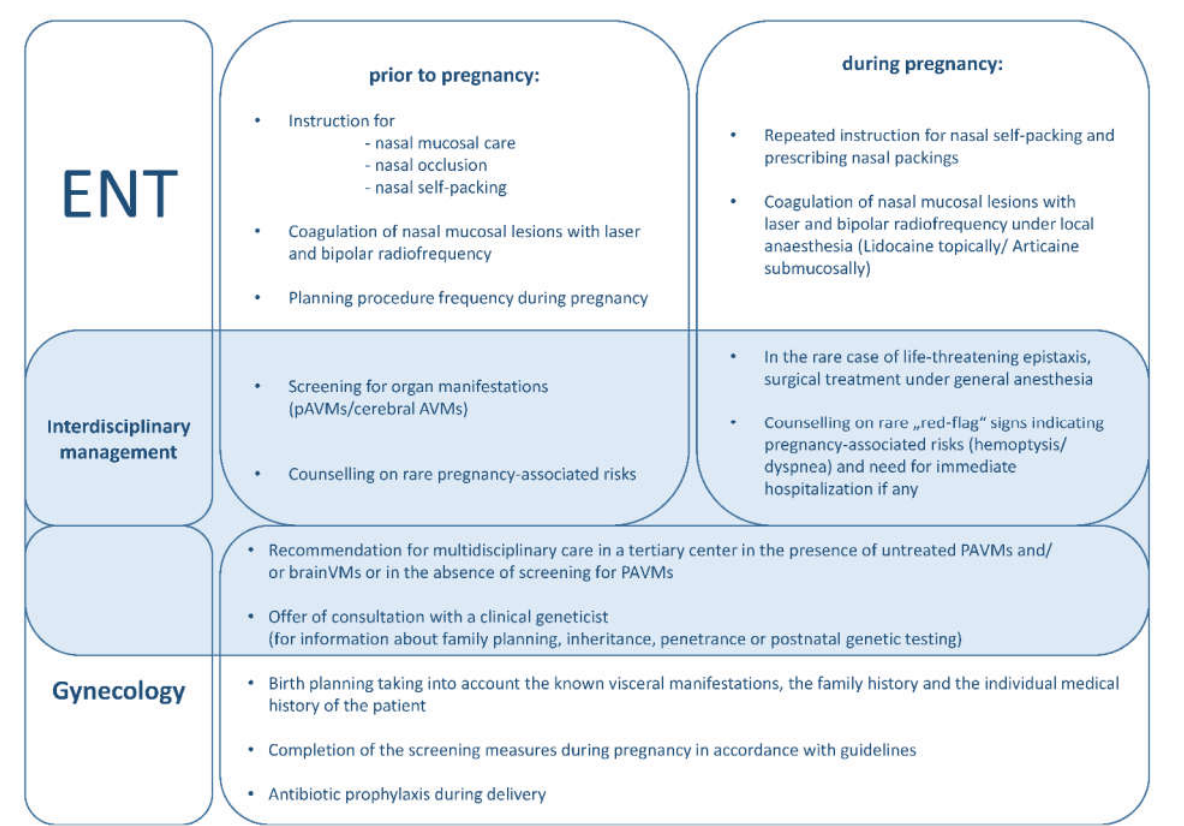
Figure 3. Recommendations for Management of HHT-related Epistaxis and Pregnancy from an Otorhinolaryngology Perspective. Items “Interdisciplinary management” and “Gynecology” in keeping with general advice with [10,12]. ENT= Ear, nose and throat physician; HHT= Hereditary hemorrhagic telangiectasia.